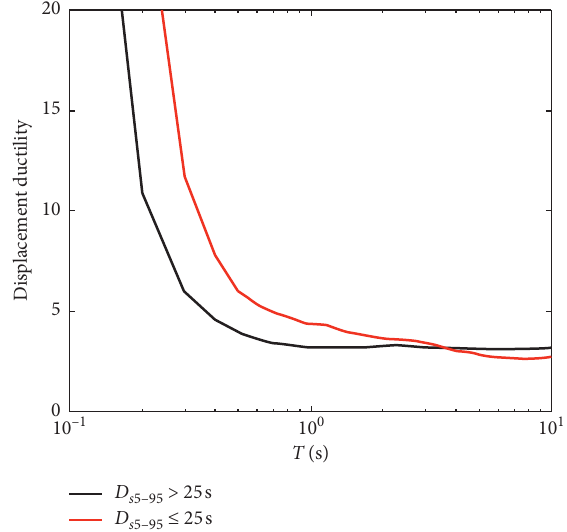
Figure 14: Effect of D s 5 − 95 on the variation of the mean constant- strength ductility